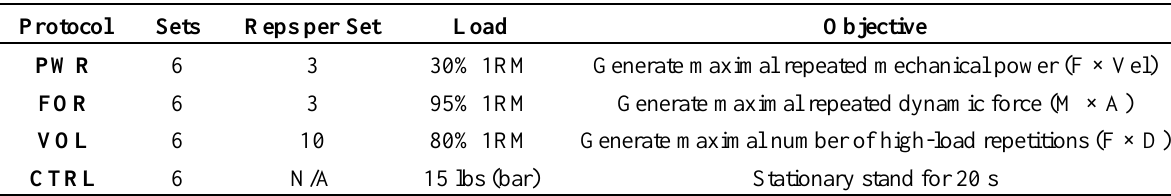
Table 3. Physical Characteristics of Experimental Protocols. Rest period was three minutes between sets. Reps = repetitions of the squat movement; F = force; Vel = velocity; M = mass; A = acceleration due to gravity; D = displacement. The mean one-repetition maximum (1RM) was 174 ± 26 kg.